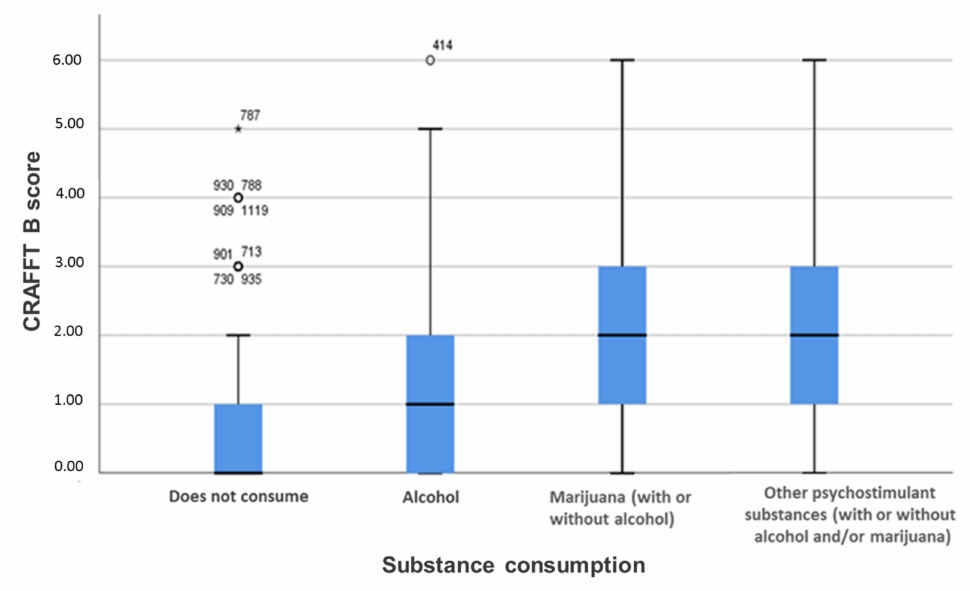
Figure 1. Substance use and consequences of its consumption.